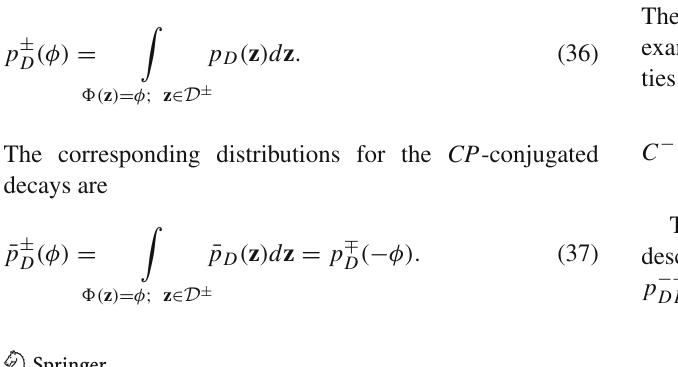
π + π − density, p + S